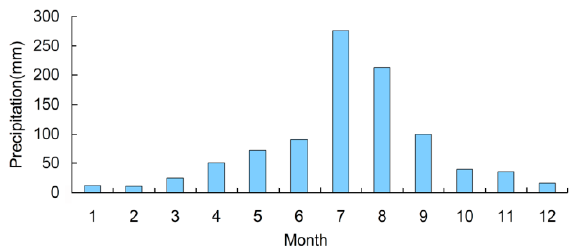
Figure 1. The monthly distribution of precipitation in the Democratic People’s Republic (DPR) of Korea.